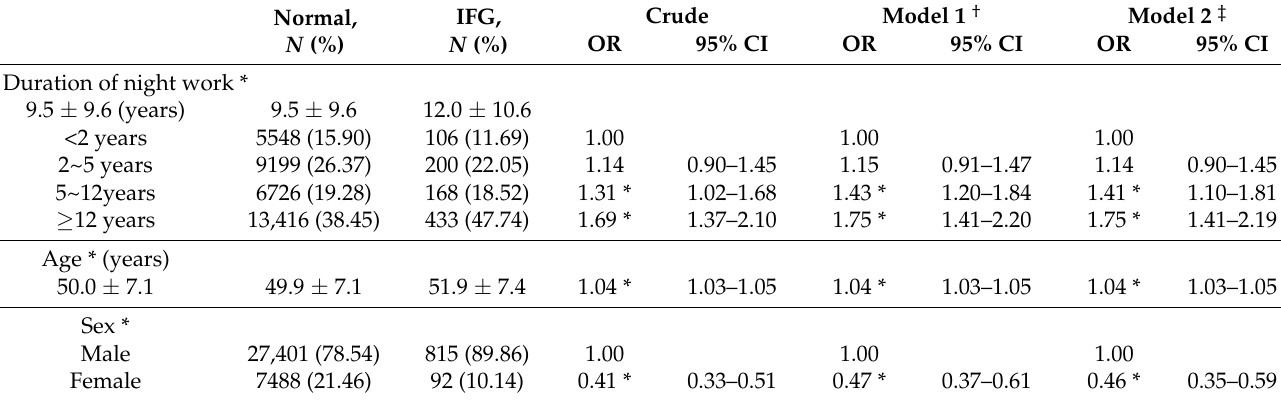
Table 3. General characteristics of participants aged >40 years and associations between these characteristics and IFG.